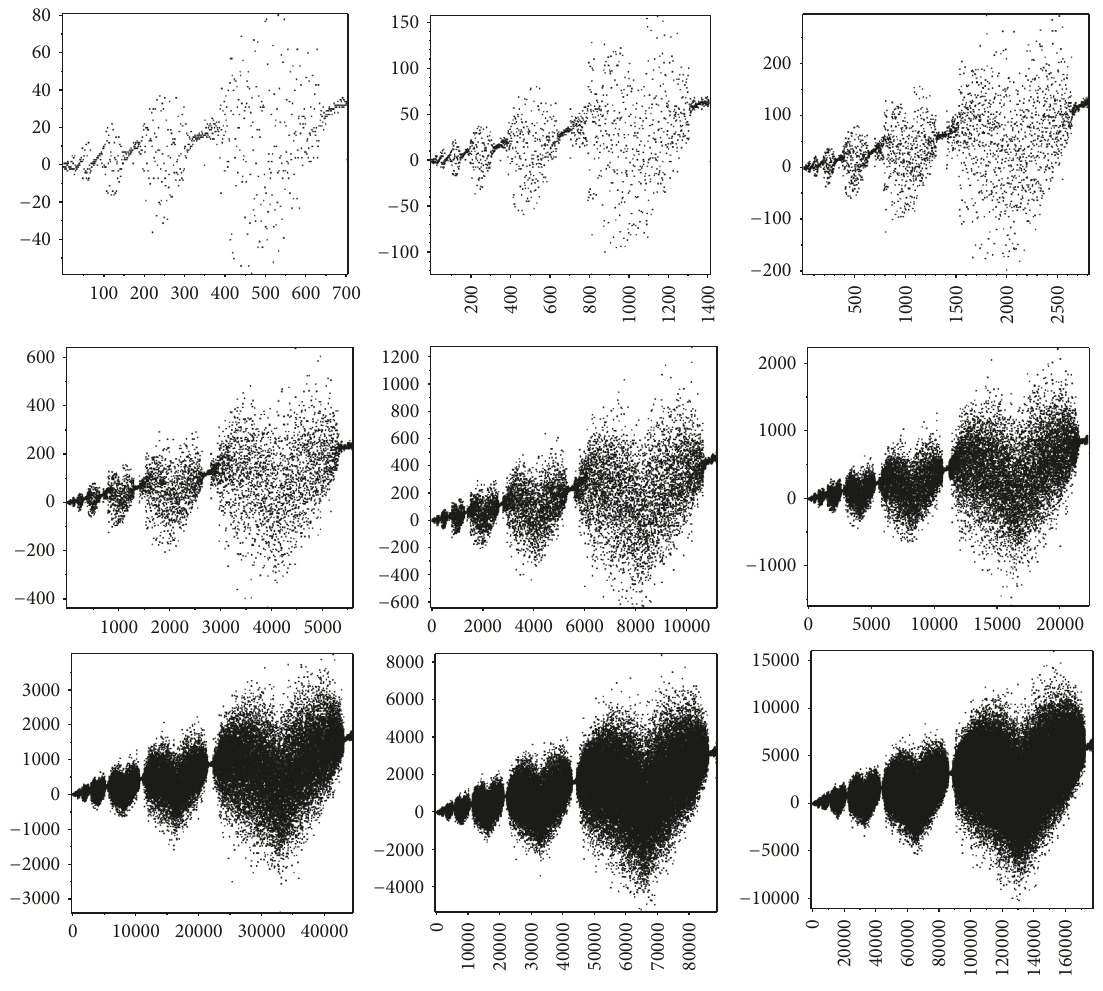
Figure 8: Heart sequence 𝐶(𝑛) − 𝑄 𝑏 (𝑛) , successive generations.